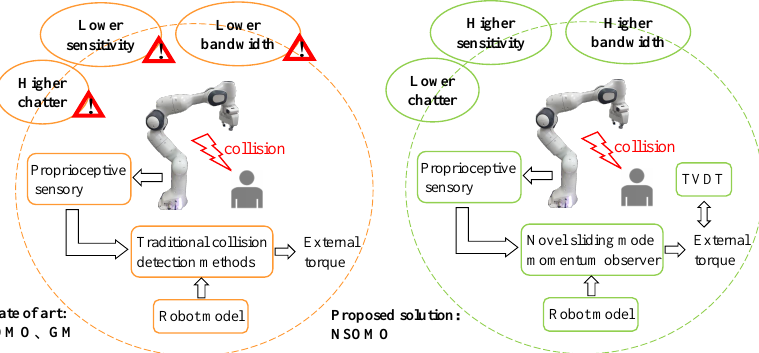
Figure 1. Schematic comparision of GM and SOMO with the proposed